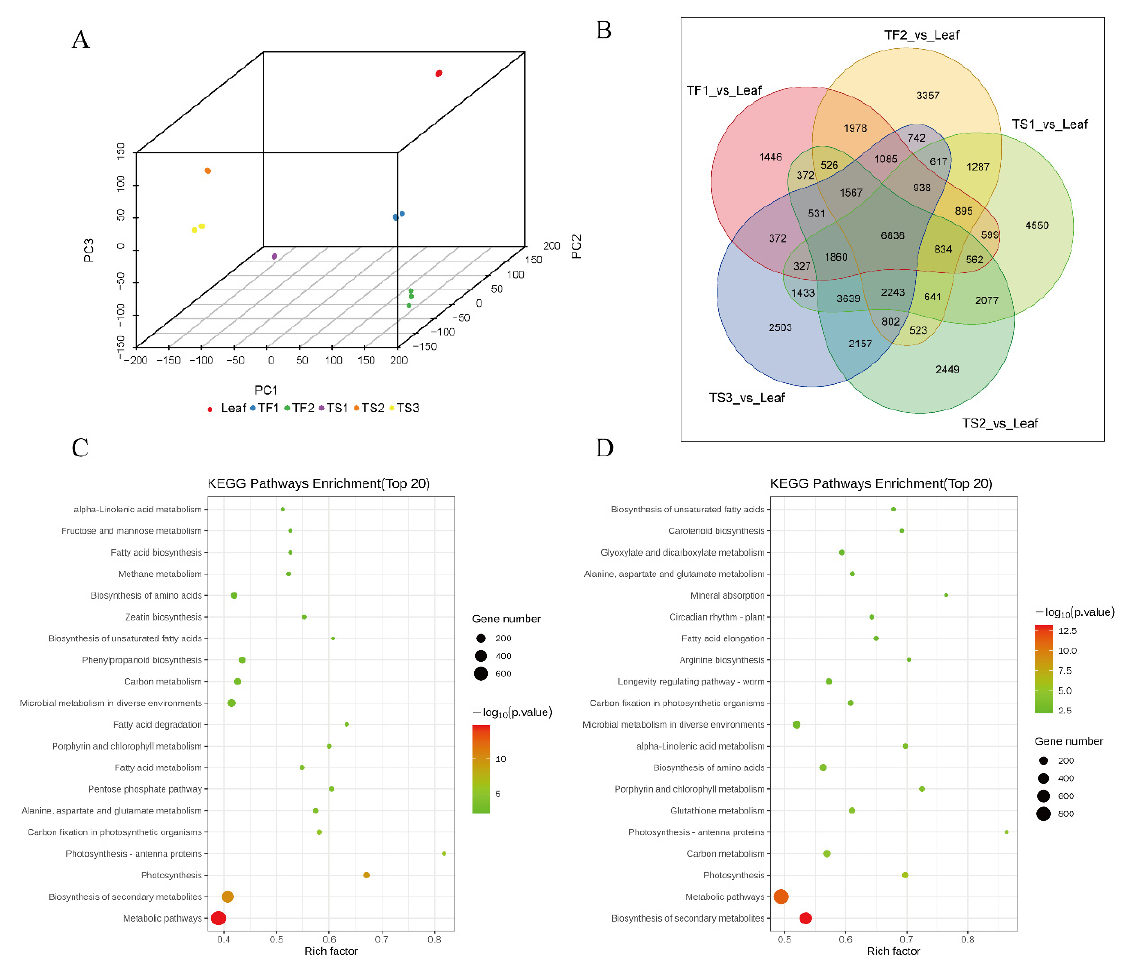
Figure 2. Comparative transcriptome analysis of tea leaves, flowers and seeds at different develop- mental stages. ( A ) Principal component analysis (PCA) of samples. ( B ) Venn diagram of DEGs in five comparison groups. ( C ) KEGG annotation of DEGs of TF1 vs. leaf. ( D ) KEGG annotation of DEGs of TS2 vs. leaf.